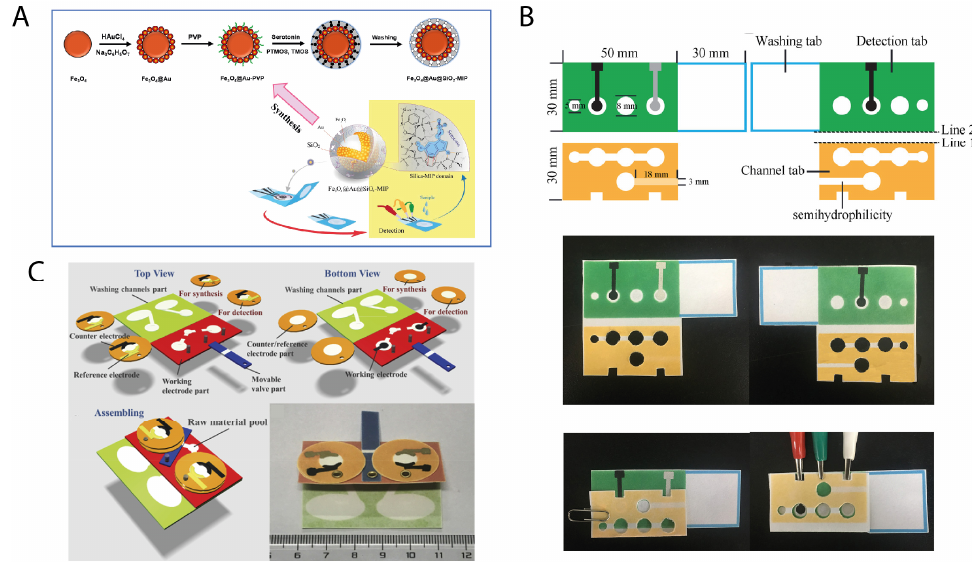
Figure 4. ( A ) Highly sensitive and selective electrochemical paper-based device using a graphite screen-printed electrode modified with molecularly imprinted polymers coated Fe 3 O 4 @Au@SiO 2 for serotonin determination. Reprinted with permission from [47], 2019 Elsevier; ( B ) ultrasensitive microfluidic paper-based electrochemical/visual biosensor based on spherical-like cerium dioxide catalyst for miR-21 detection. Reprinted with permission from [48], 2019 American Chemical Society; ( C ) the strategy of antibody-free biomarker analysis by in-situ synthesized molecularly imprinted polymers on movable valve paper-based device. Reprinted with permission from [49], 2019 Elsevier.